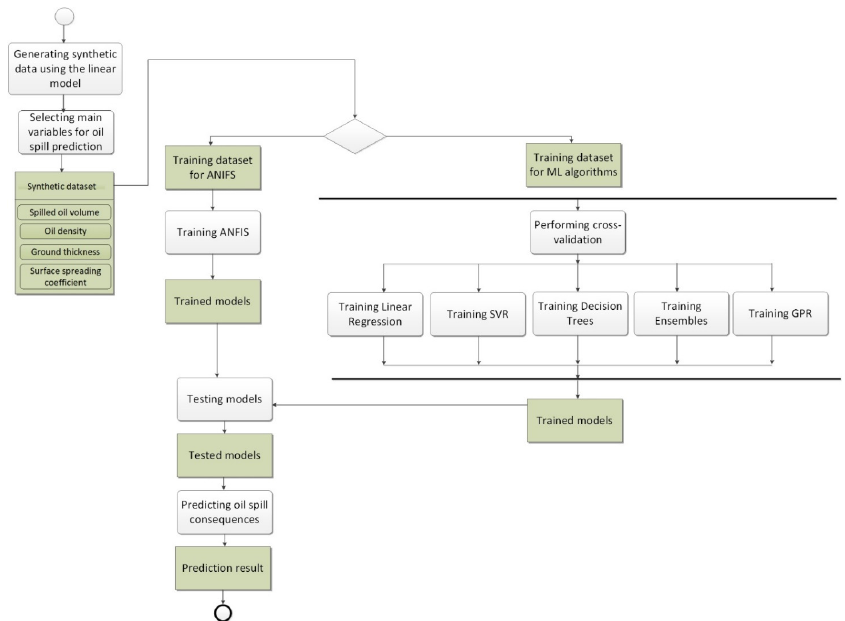
Figure 1. The schema of the approach for the prediction of the consequences of oil spills on the ground